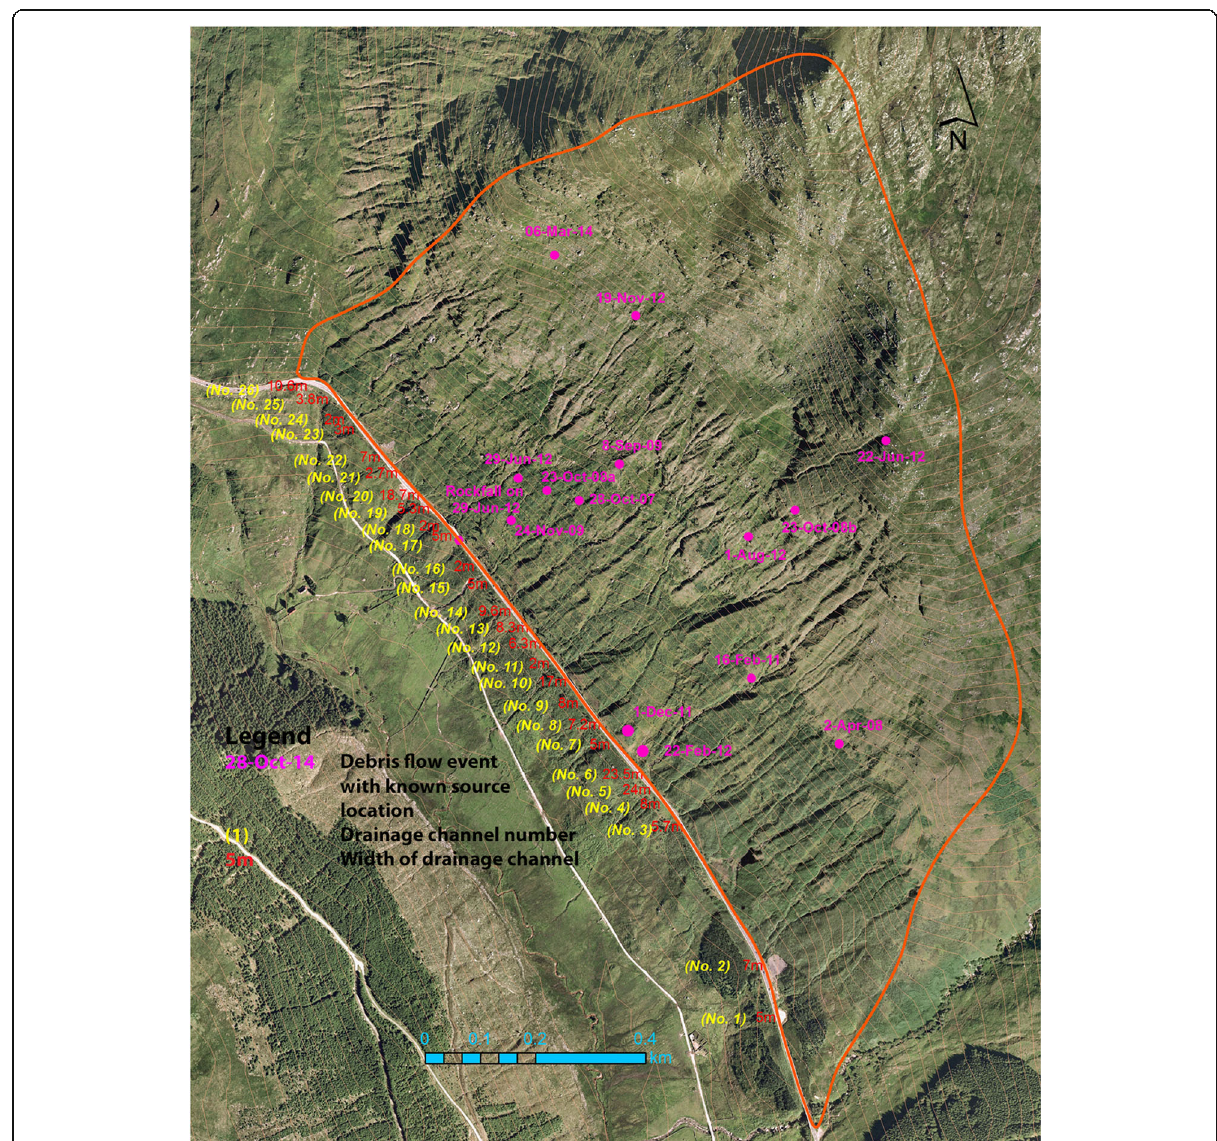
Fig. 5 Locations of the drainage channels at the A83 Rest and be Thankful as confirmed by field reconnaissance. Base aerial